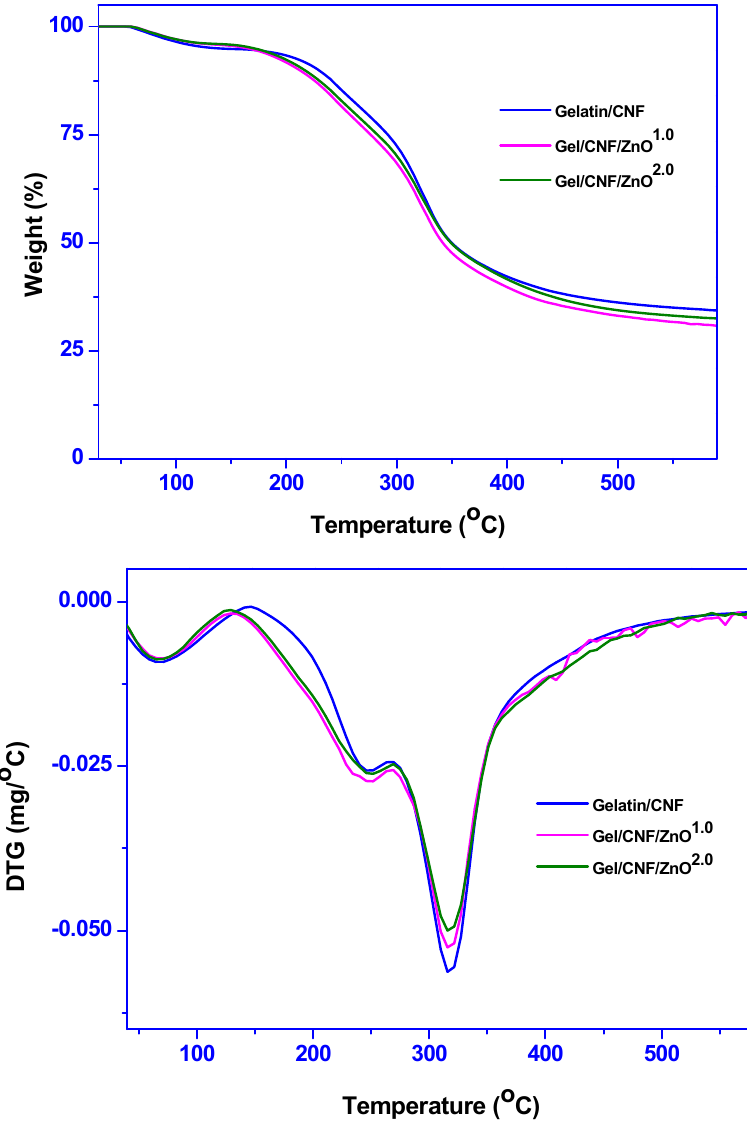
Figure 4. TGA and DTG thermograms of the gelatin/CNF ‐ based films.